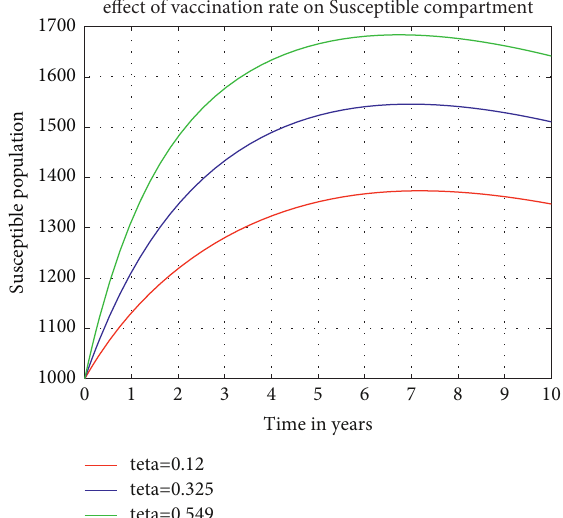
Figure 16: Effect of vaccination rate on susceptible population.